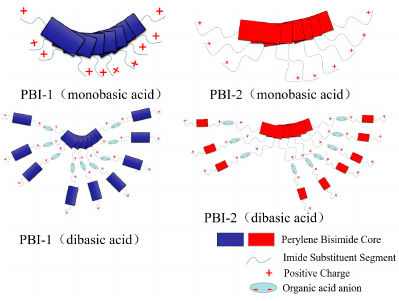
Figure 8. Proposed schematic diagrams of self-assembly for PBI-1 and PBI-2.